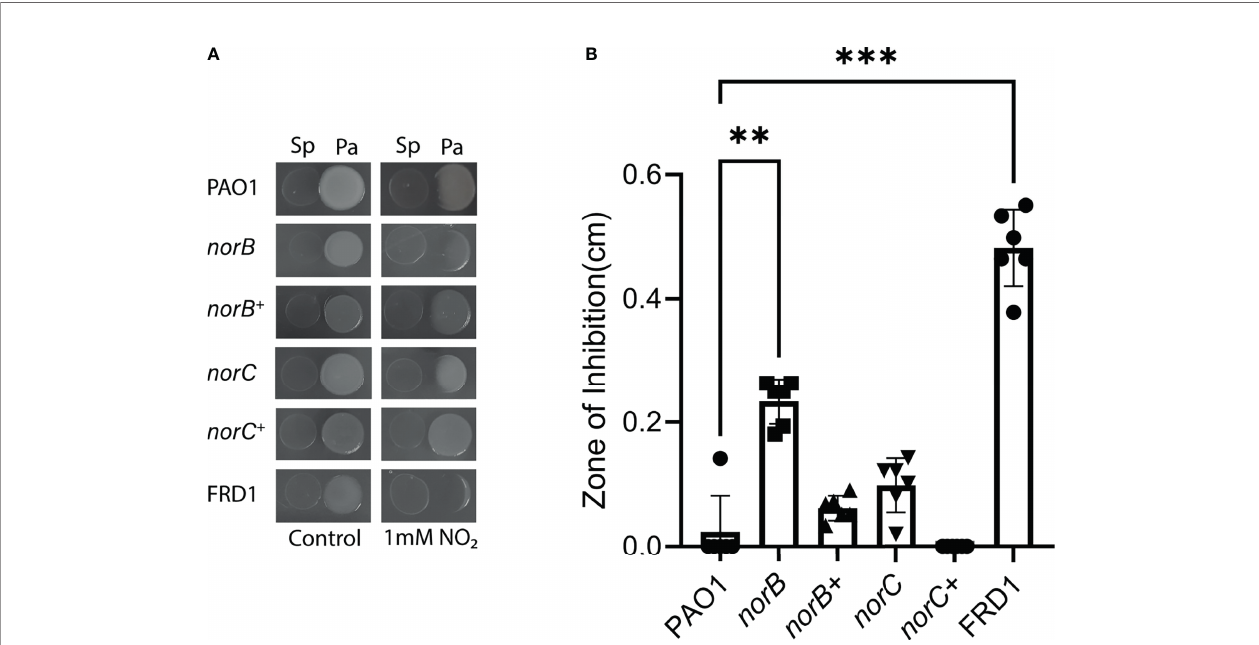
FIGURE 2 | norB and norC are required for resistance to reactive nitrosative intermediates. (A) P. aeruginosa PAO1 , norB mutant , norB + complemented , norC mutant, and norC + complemented, and FRD1 strains were spotted next to S. parasanguinis in the presence or absence of 1mM nitrite. (B) Zones of inhibition in the presence of S. parasanguinis and nitrite were quanti fi ed for PAO1, norB mutant , norB + complemented , norC mutant , norC + complemented, and FRD1 strains. n = 6, 3 biological replicates with 2 technical replicates, error bars represent standard deviation, **P < 0.01, ***P < 0.001 (Kruskal-Wallis, Dunnett Post Hoc